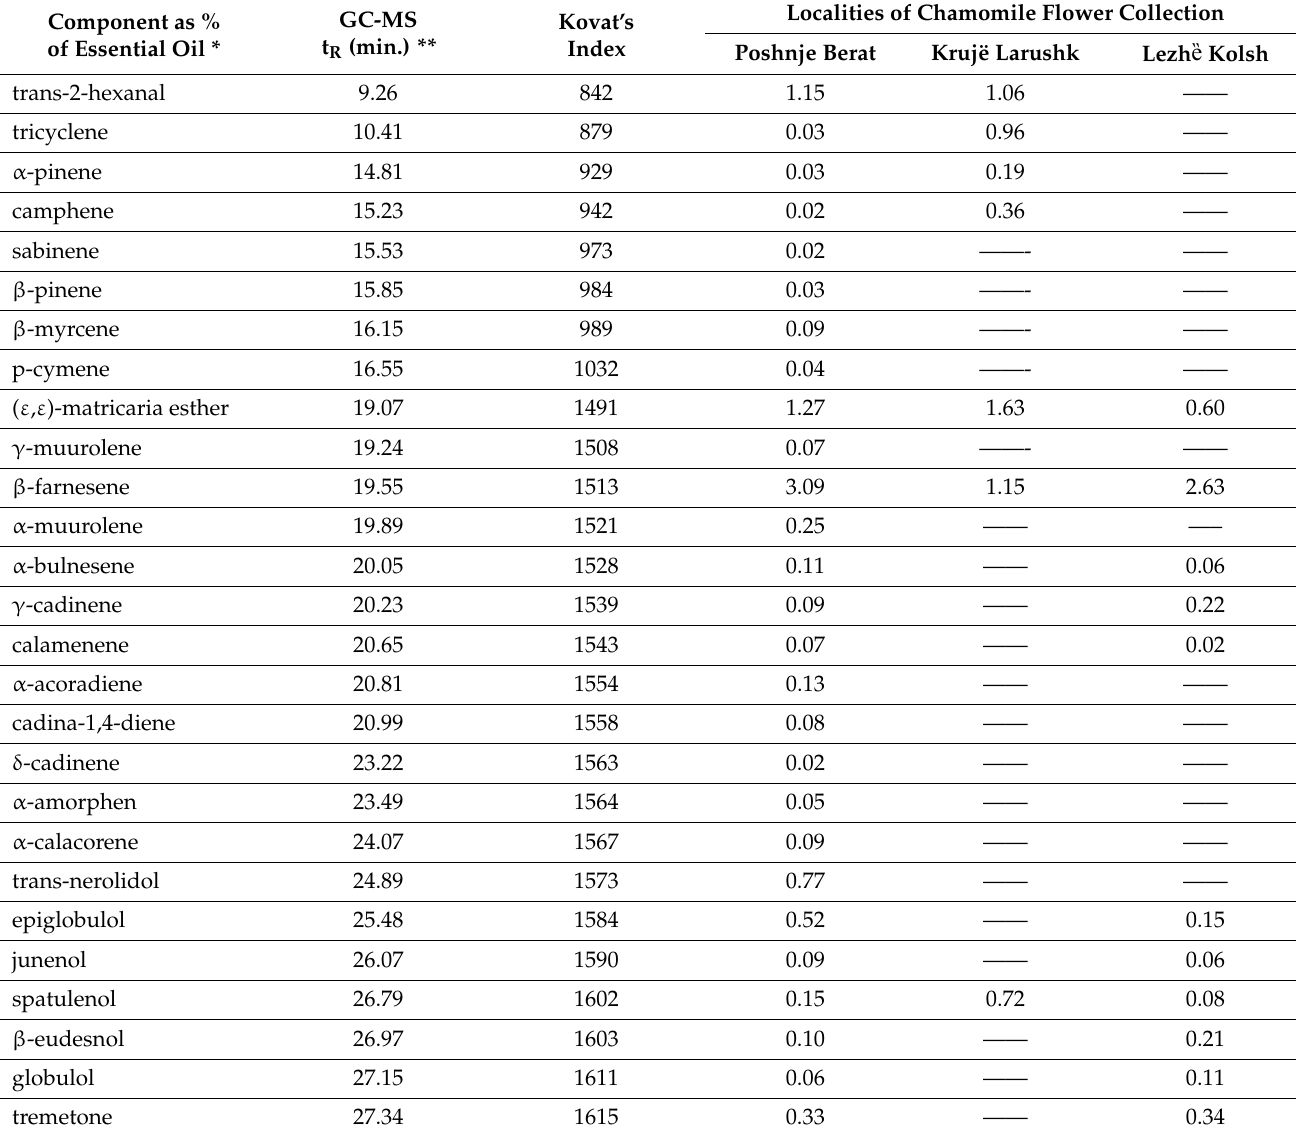
Table 4. The marked differences in chemical composition of chamomile essential oil from tree localities in central Albania